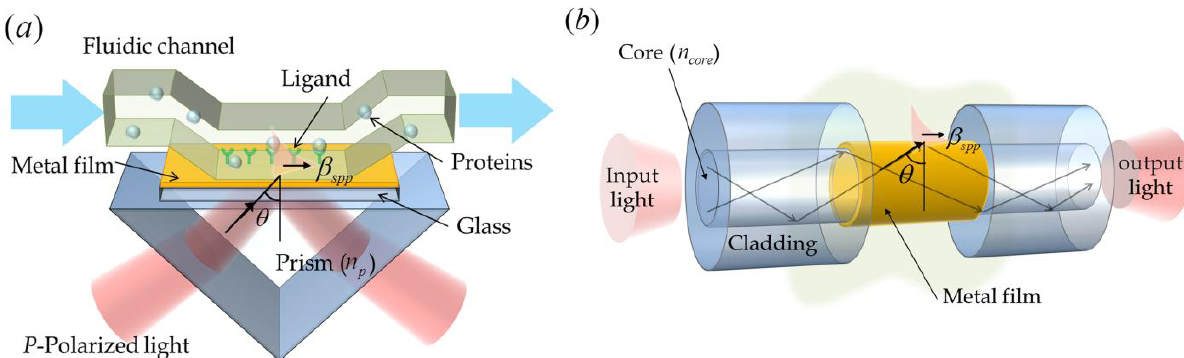
Figure 1. Basic schemes for SPR sensors with ( a ) Kretschmann configuration based coupling; ( b ) waveguide based coupling; ( c ) and grating coupling; ( d ) Reflection ratio of light due to SPR with angular modulation or wavelength